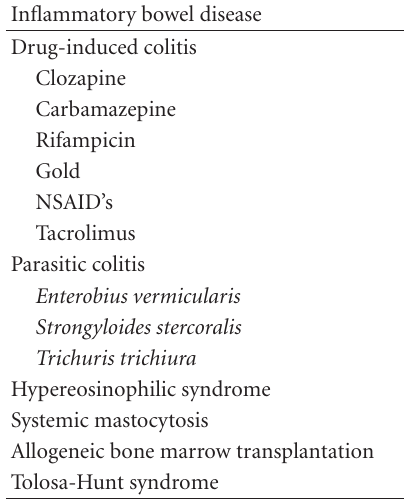
Table 2: Di ff erential diagnoses of eosinophilic colitis.